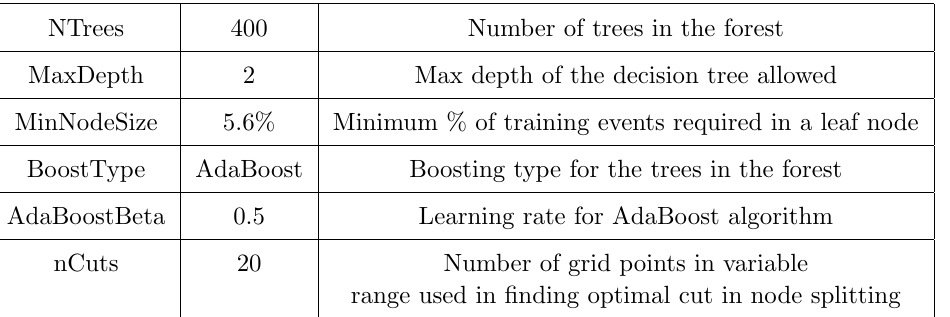
Table 5 . Parameter used in BDT